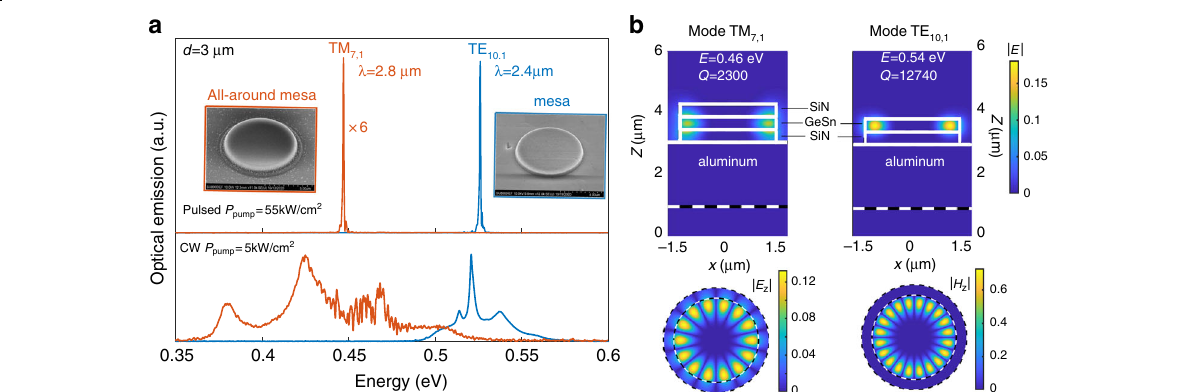
Fig. 6 Tensile strain tuning of GeSnOI laser emission. a Spectra below and above threshold density for 3 µm diameter GeSnOI mesas with (red curves) or without (blue curves) top SiN stressors. In both cases, the active GeSn layer thickness was 400 nm. b Simulated optical fi elds and theoretical Q -factor values of TM 7,1 and TE 10,1 lasing modes for a tensile-strained GeSnOI mesa with a SiN stressor on top and a quasi-relaxed GeSnOI mesa without the top SiN stressor, respectively. Calculations have been performed with an aperiodic Fourier modal method dedicated to body-of- revolution objects